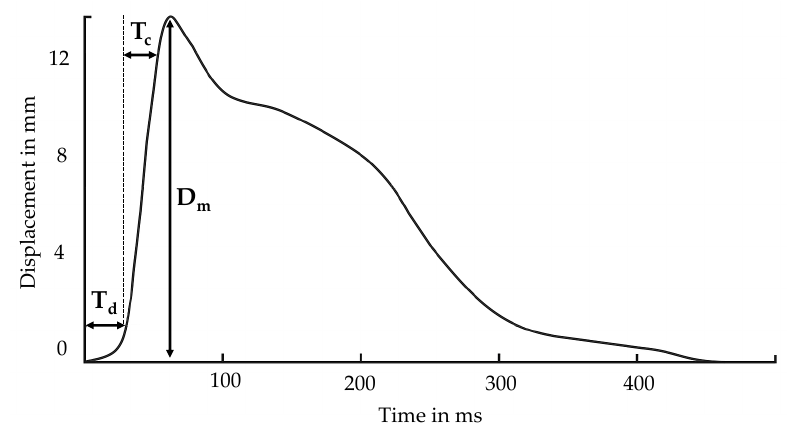
Figure 4. TMG signal with marked parameters: contraction time ( T c ), delay time ( T d ), and the maximal displacement amplitude ( D m ).